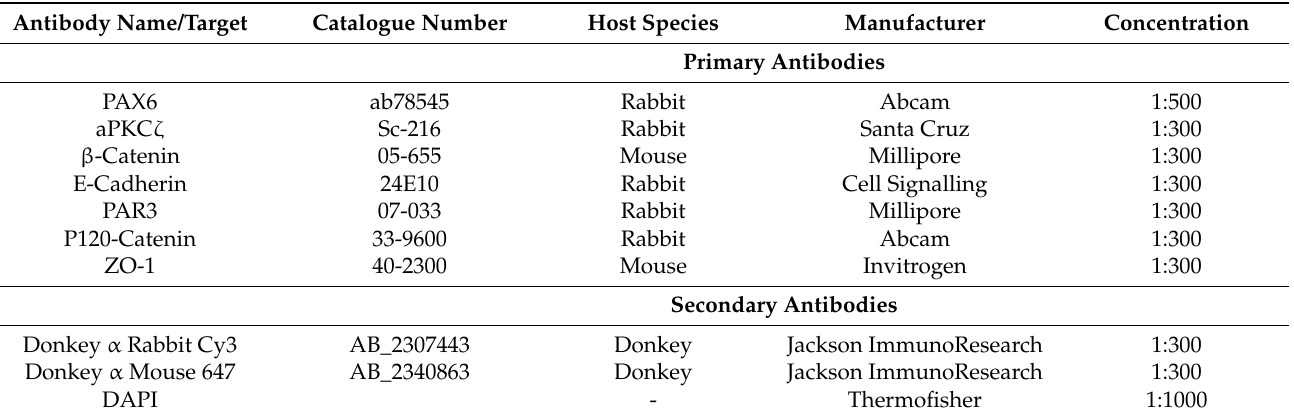
Table 2. Antibodies used for immunofluorescence histochemistry conducted on fixed MCF7 cells. Table list the name, species, manufacturer and the concentration of use for each antibody. Antibody concentrations diluted in donkey